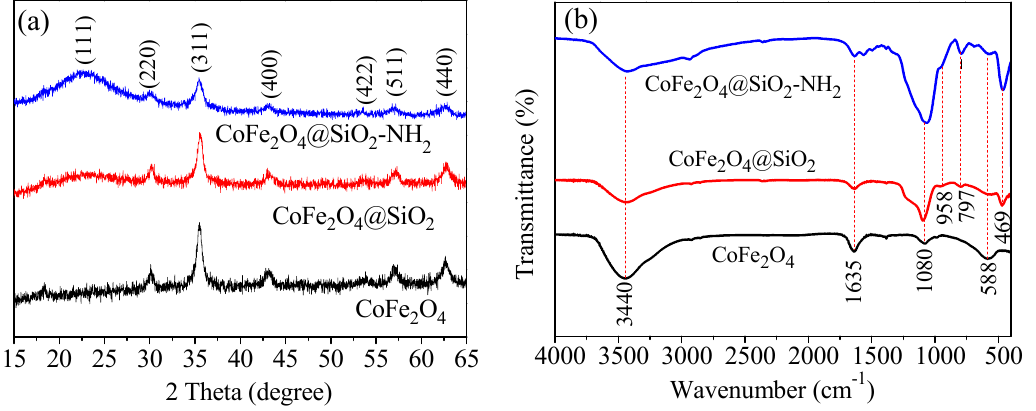
Figure 4. ( a ) XRD patterns and( b ) FTIR spectra before adsorption.